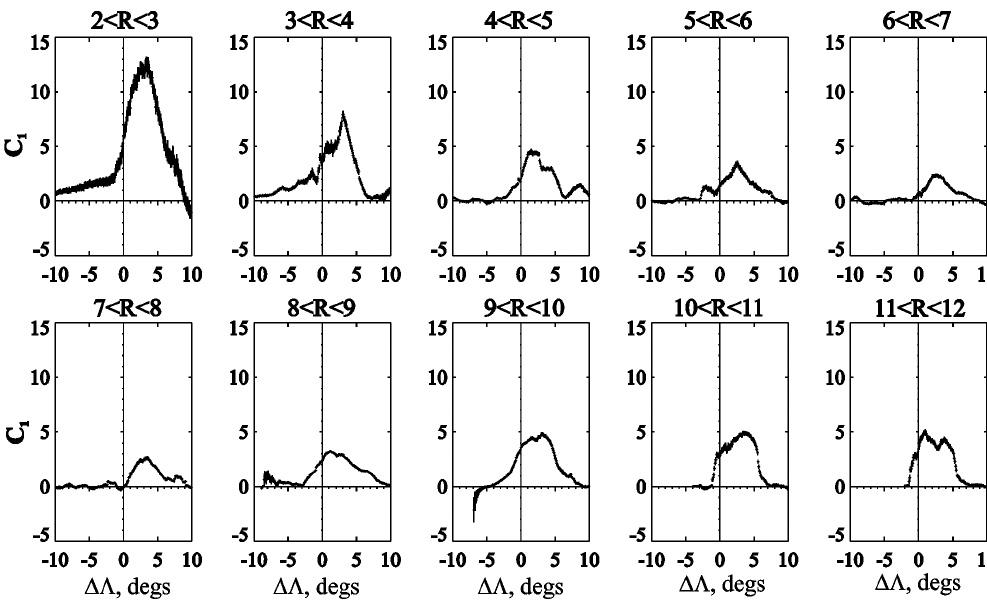
Fig. 8. Latitudinal profiles across the model cusp of the first regression coefficient C 1 of proportionality between the B y field component observed in and around the cusp and B ( IMF ) y , for 10 intervals of the radial distance R . Note a regular variation of the peak values of C 1 with growing radial distance, consistent with the model of field-aligned cusp currents, responsible for the observed “penetration” of the IMF B y